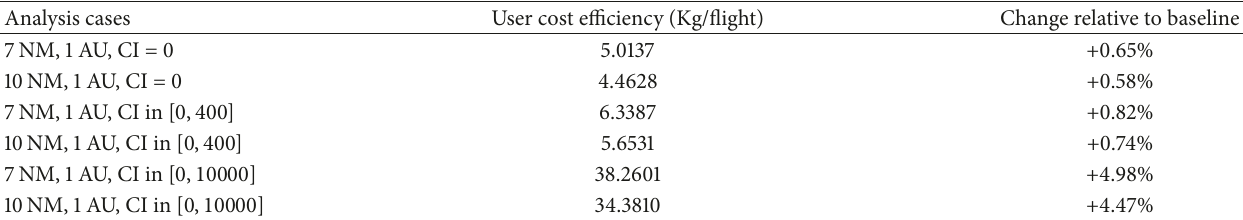
Table 4: Variation in the average user cost efficiency per flight with the version of the algorithm used for different CI allocations. Analysis